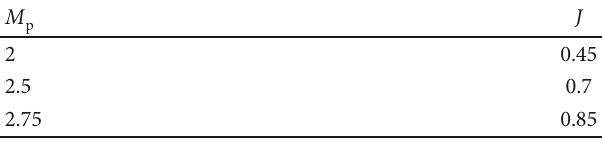
Table 3: Momentum fl ux ratio J with injection location.